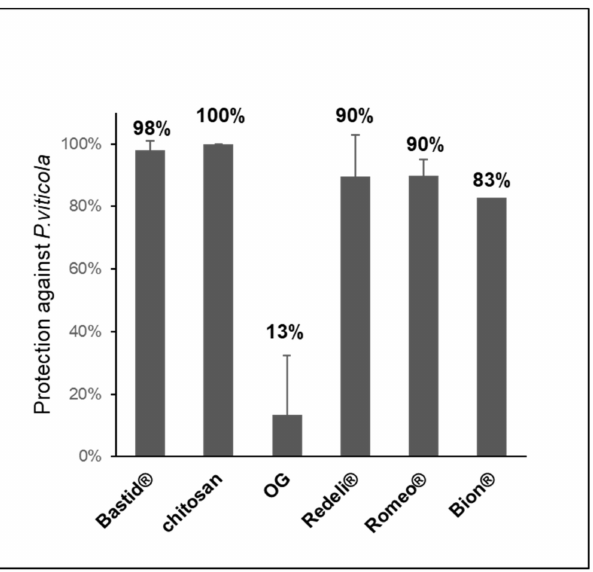
Figure 4. Induced resistance assays. Six elicitors were tested for their efficiency in protecting grapevine against downy mildew ( P. viticola ). Bastid ® (0.8 mL/L, 4 assays), Romeo ® (2 g/L, 2 assays), Redeli ® (1 g/L, 2 assays), OG (2.5 g/L, 2 assays), and chitosan (1 g/L) and Bion ® (0.5 g/L, 1 assay). Protection levels (%) were calculated based on comparisons of the sporulating leaf area with the H 2 O control considered as 0%